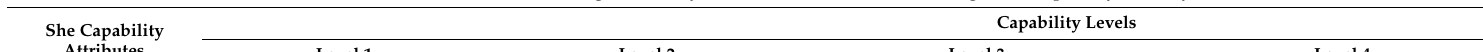
Integrated Safety, Health and Environmental Management Capability Maturity Model